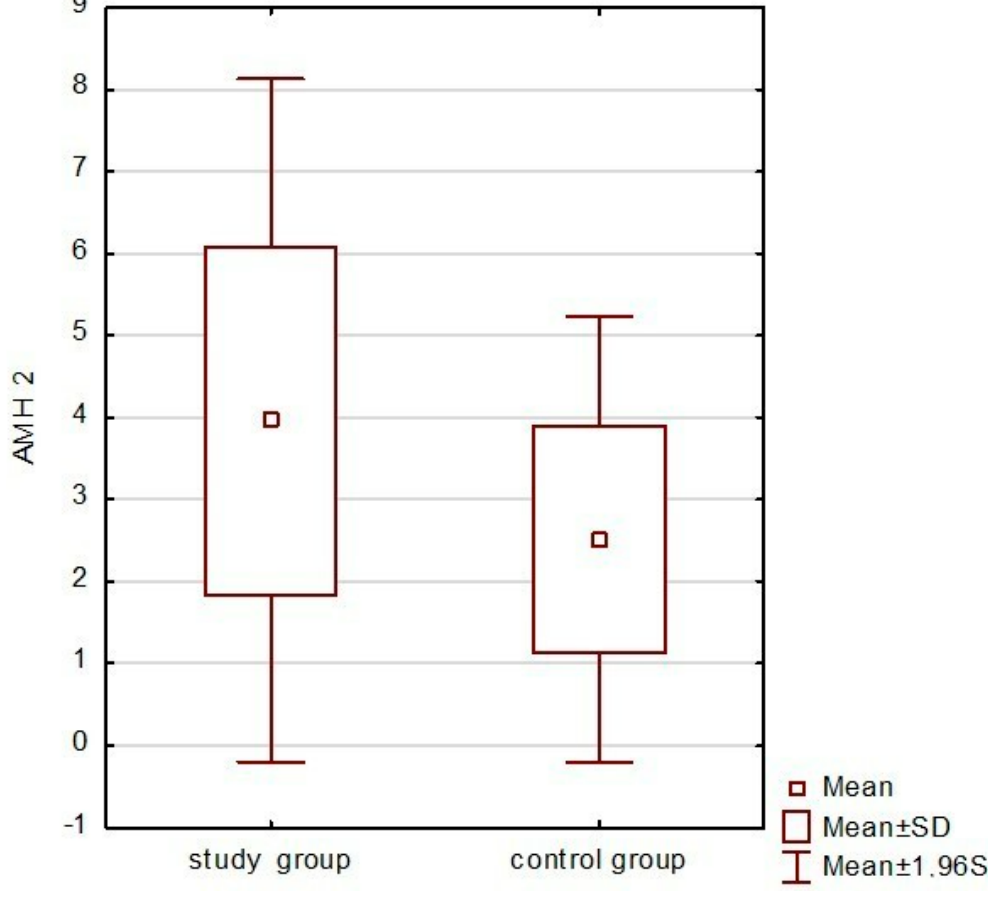
Figure 2. AMH levels 6 months after surgery. Table 4. Comparison of AMH levels before surgery and 6 months after surgery.